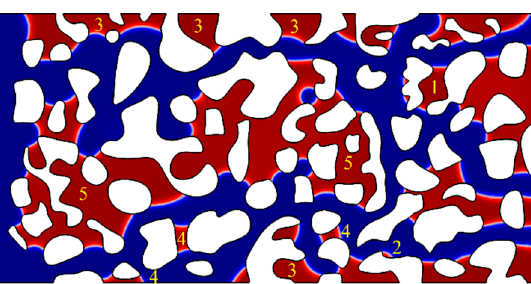
Figure 3. Residual oil distribution in the oil-wet porous medium when the water cut is 98%. The white regions are rock matrix, and the red and blue regions represent oil and water, respectively. (1) isolated oil droplet; (2) oil film; (3) residual oil in dead ends; (4) residual oil in pore throats; and (5) cluster residual oil.